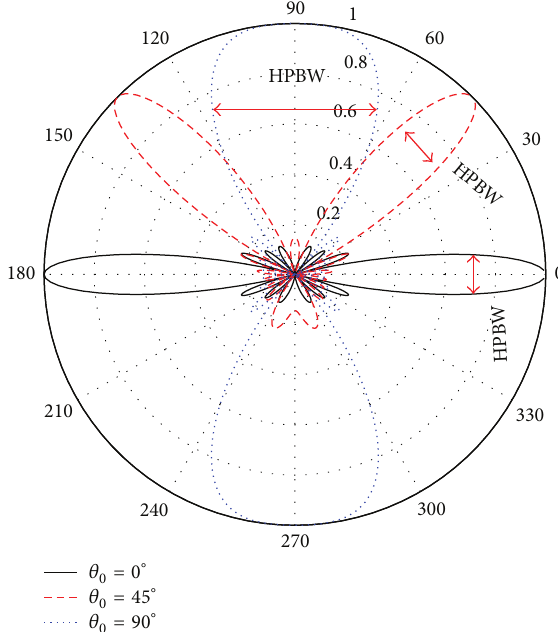
Figure 2: Illustration of the off-boresight angle effect.